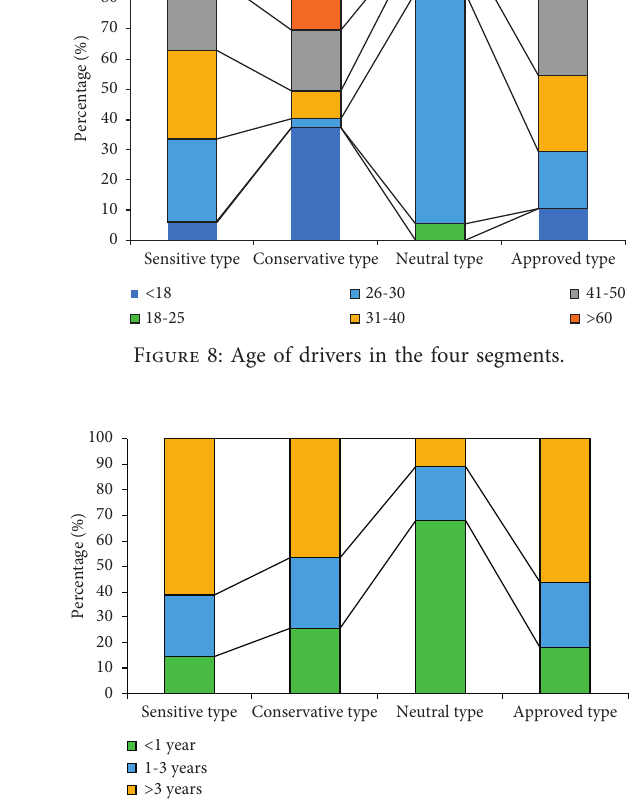
Figure 9: Driving experience of drivers in the four